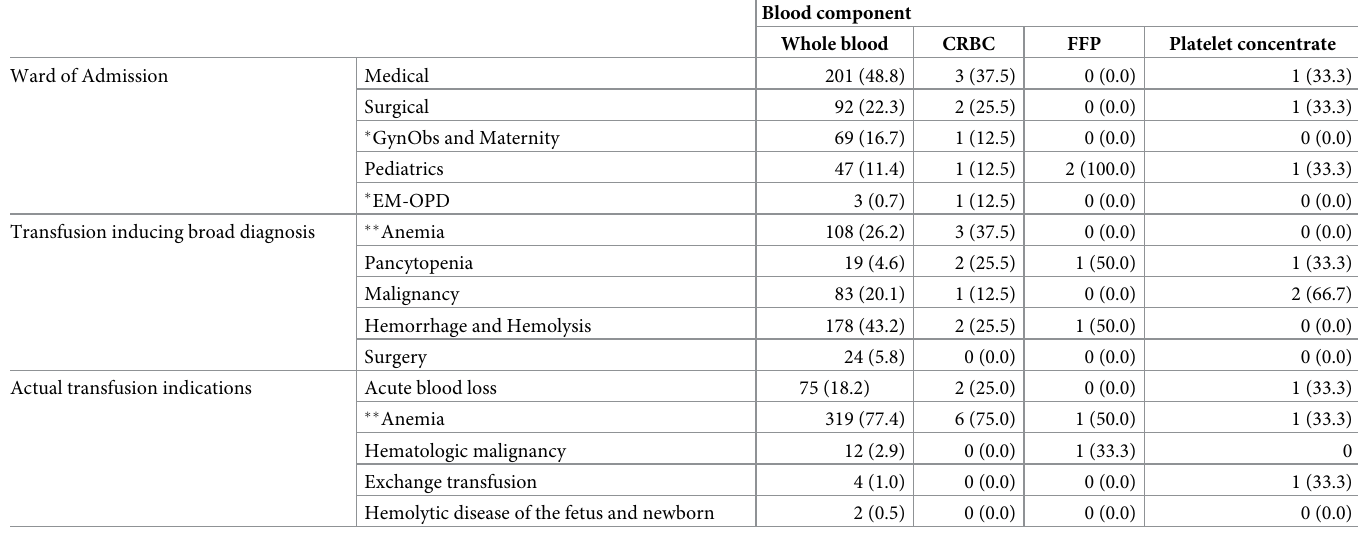
Table 4. Utilization of blood components across different clinical departments, JMC, southwest Ethiopia, February 1 to June 30,